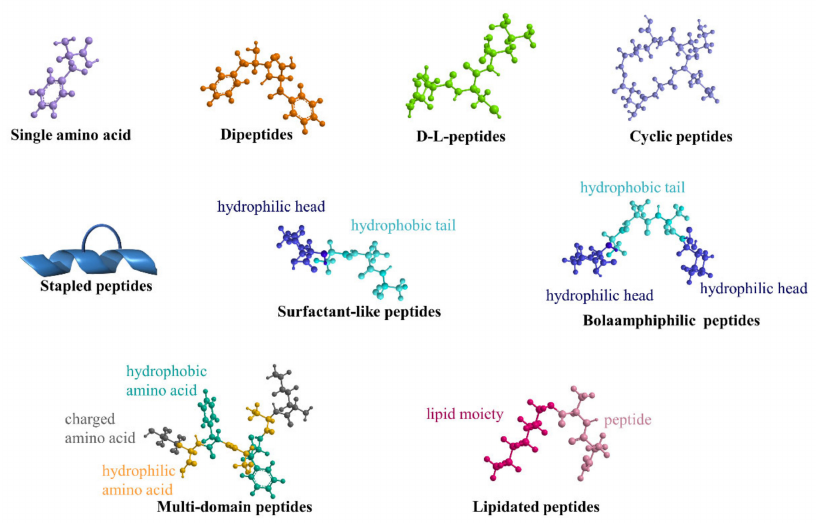
Figure 1. Schematic representation of the most common building blocks to obtain SAPs described in this